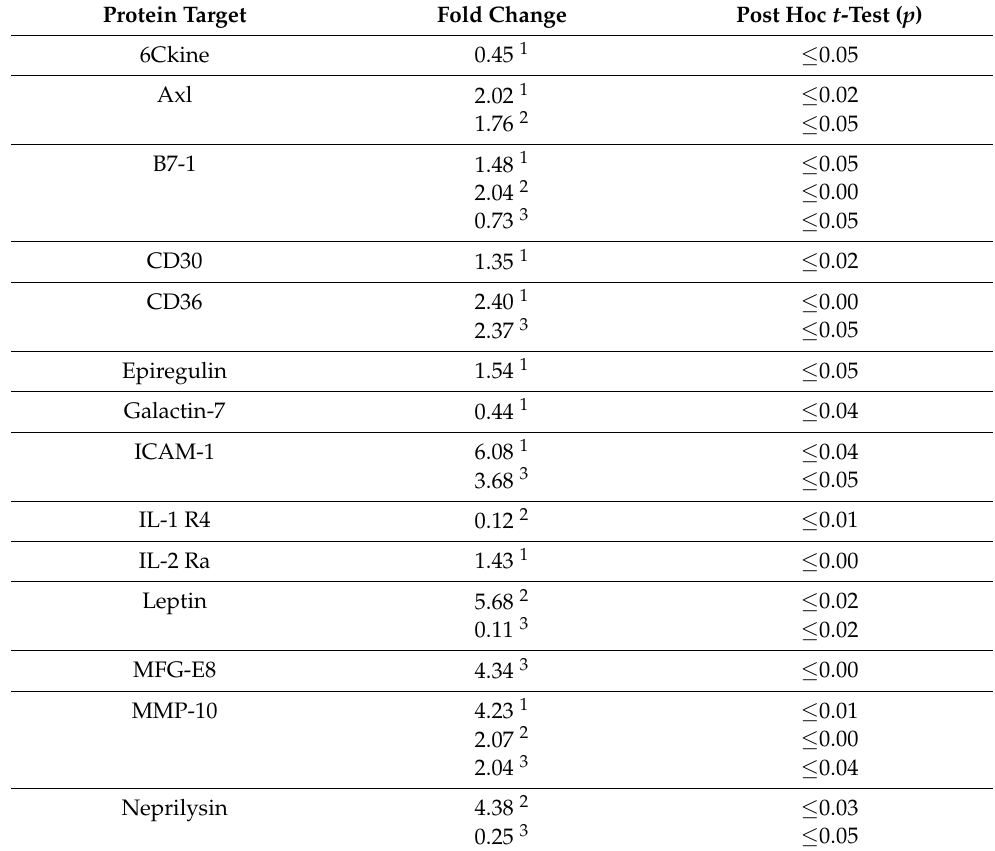
Table 1. Differentially expressed plasma proteins in WT mice dependent on diet.